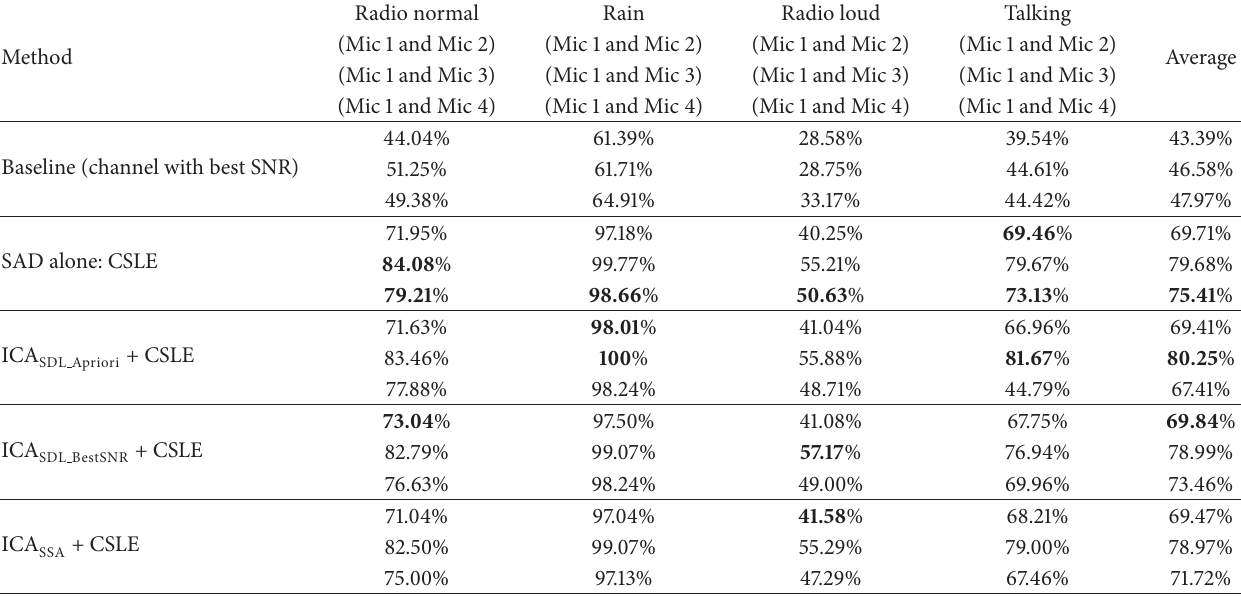
Table 4: Classification accuracy of promising system configurations, for all three microphone configurations of the noisy SDL database, across four different noise